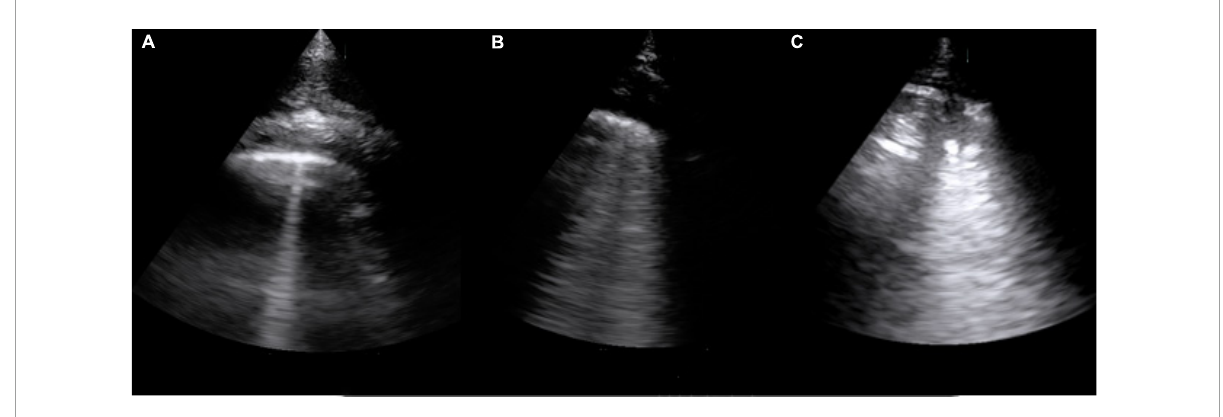
FIGURE1 Example of most significant findings in a subject from the CP group. (A) B-line; (B) confluent B-lines; and (C) consolidation.